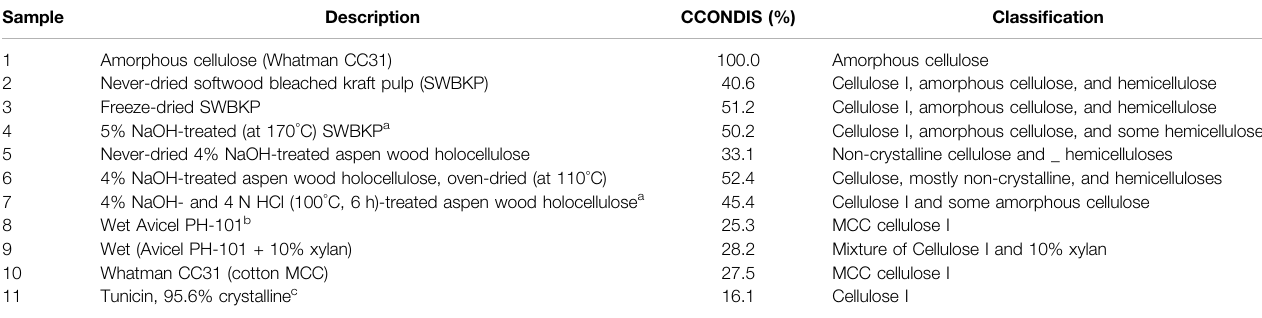
TABLE 3 | Chain conformational disorder (CCONDIS).